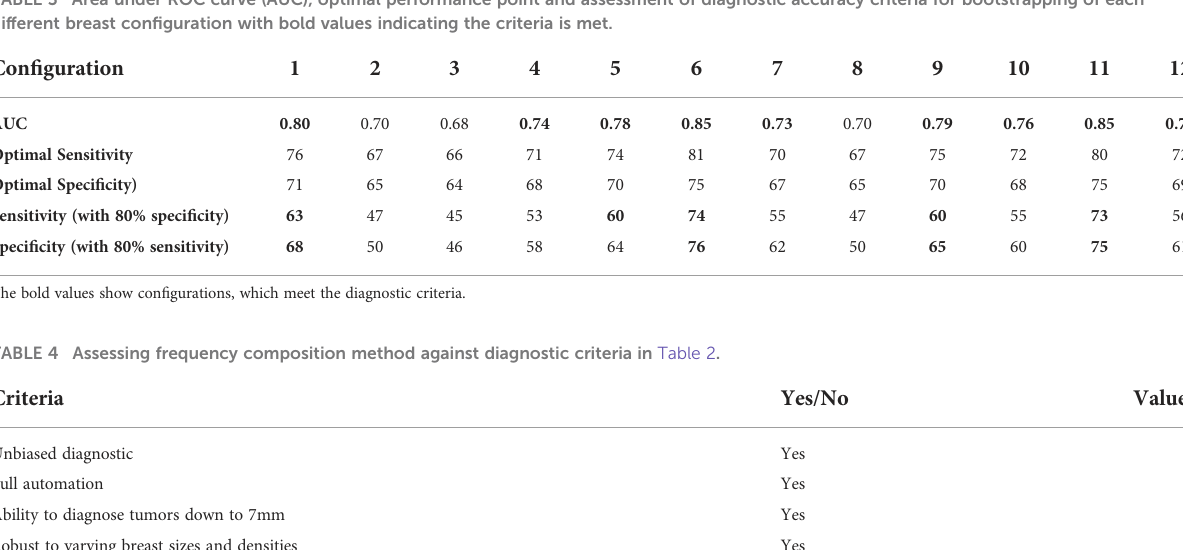
TABLE 3 Area under ROC curve (AUC), optimal performance point and assessment of diagnostic accuracy criteria for bootstrapping of each different breast con fi guration with bold values indicating the criteria is met. Con fi guration 1 2 AUC Optimal Sensitivity